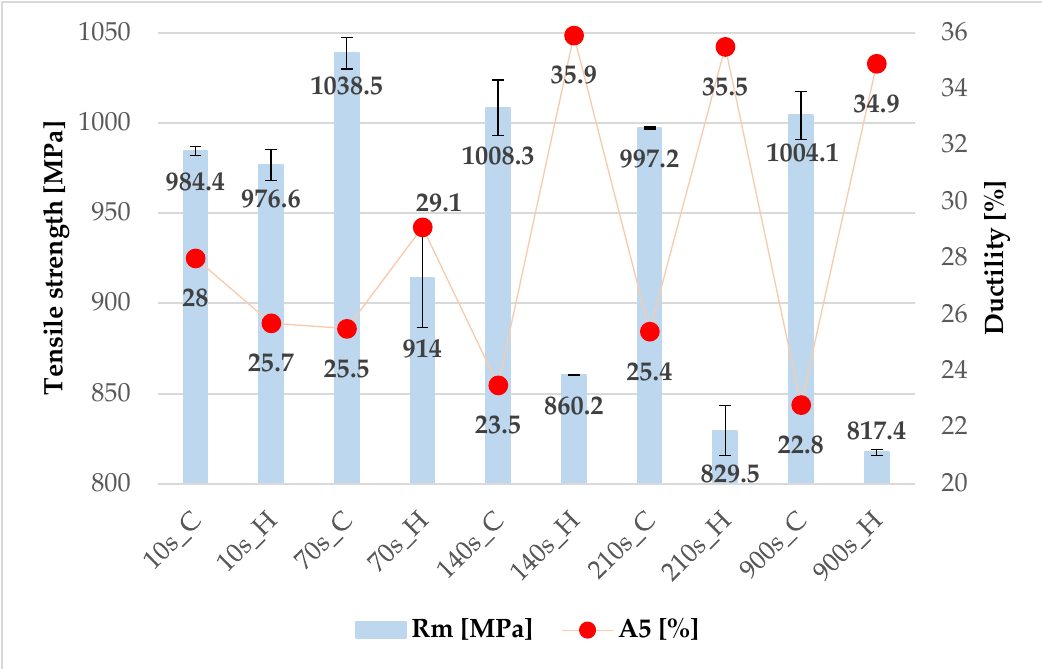
Figure 12. Mechanical properties for 20MnAl steel (cooled (C) and heated (H) part). Table 4. Hardness of 20MnAl steel in different parts of the sheet.